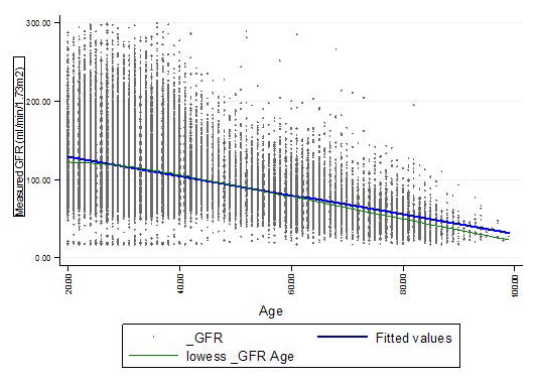
Table 1. Comparison of mean and standard deviation of GFR in different age groups based on sex Age (y)